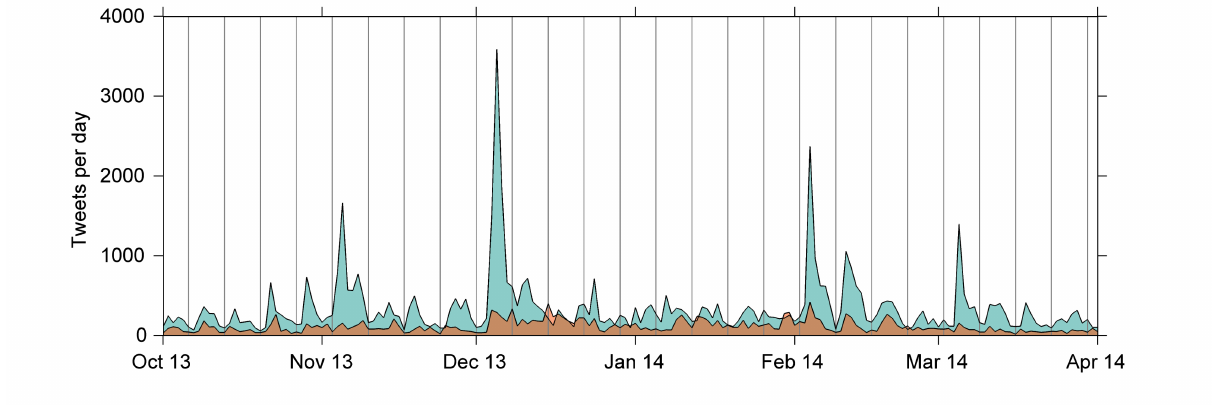
Figure 1. The number of tweets posted each day during the data collection period, including tweets rejecting the safety or value of HPV vaccines (orange) and all other HPV vaccine tweets (cyan). Gray vertical lines indicate Sundays. No corrections for time zone differences were applied.